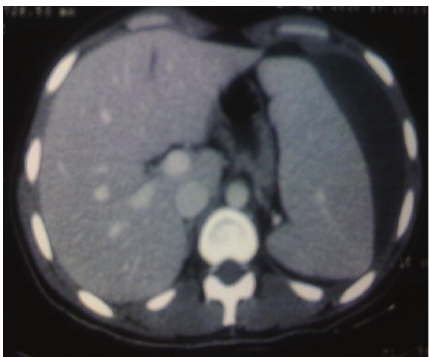
Figure 4: CT, two weeks after patient’s admission, showed the same splenic